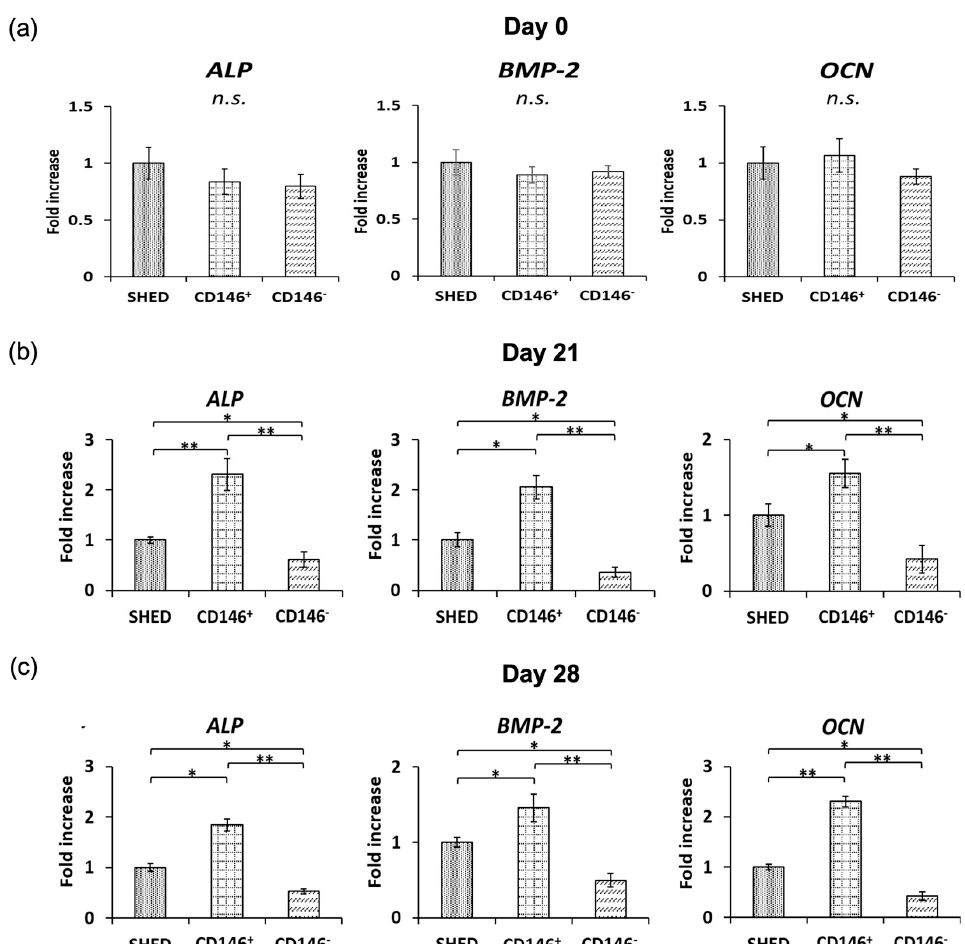
Figure 2. Gene expression in relation to bone differentiation on days 0, 21, and 28 of induction of bone differentiation. ( a ) Uninduced osteogenic differentiation. No significant differences were found among SHED, CD146 + SHED, and CD146-SHED in the gene expression of ALP, BMP-2, and OCN ( n = 5, Not significant; N.S.). ( b , c ). Induced osteogenic differentiation on days 21 and 28. CD146 + SHED showed significantly higher gene expression of ALP, BMP-2, and OCN than SHED and CD146-SHED ( n = 5, Kruskal–Wallis method, ** p < 0.01, * p <